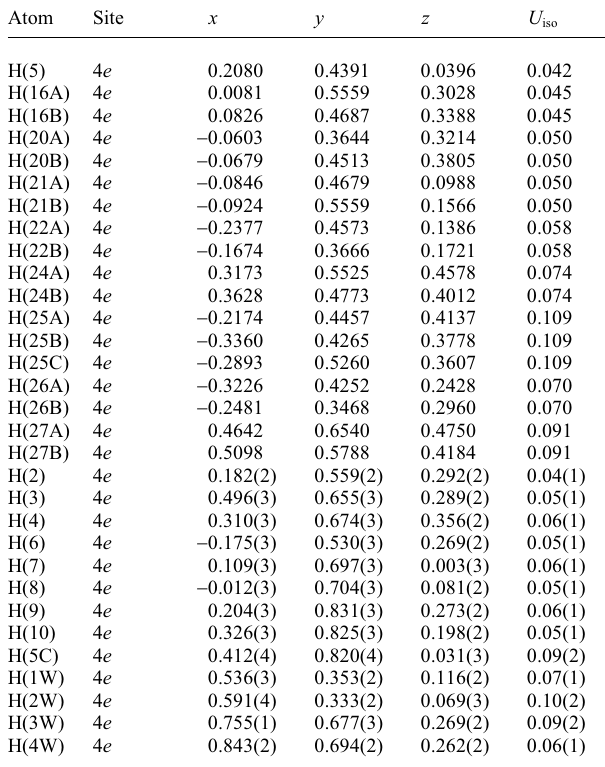
Table 2. Atomic coordinates and displacement parameters (in Å 2 )